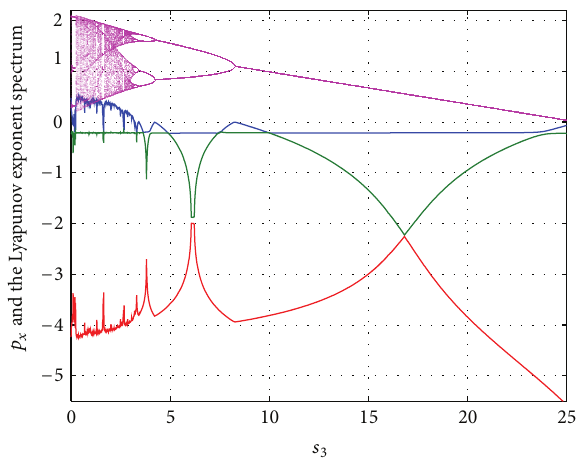
Figure 4: The Lyapunov exponent spectrum (blue, green, and red) and bifurcation of 𝑝 𝑥 (pinkish red) versus the parameters 𝑠 3 when s 2 = 0.2 .